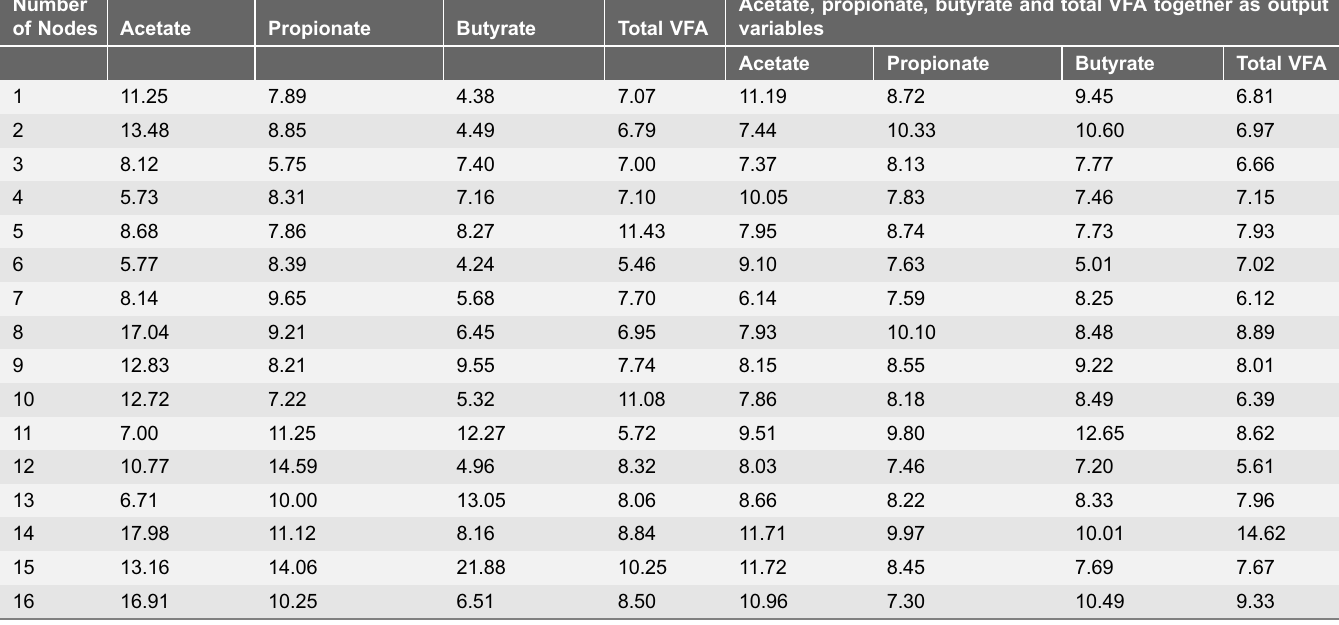
Table 7. The RMSPE (%) between the observed and the predicted values with different number of nodes in the hidden layer. Number of Nodes